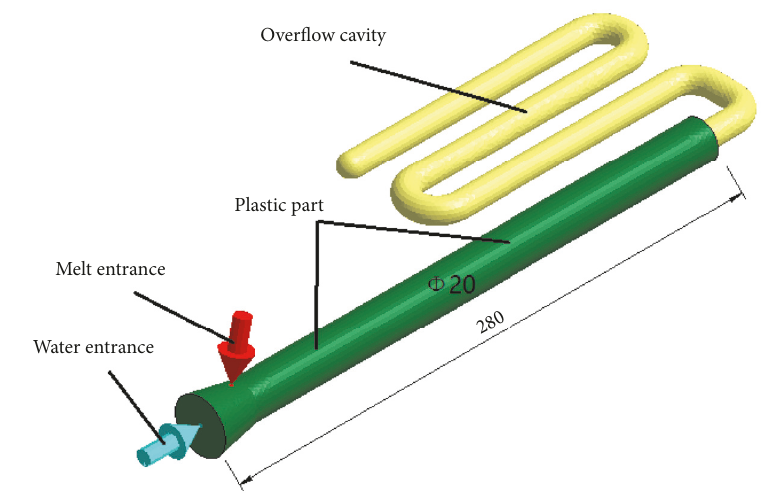
Figure 2: Geometry of the overflow water-assisted injection molding.